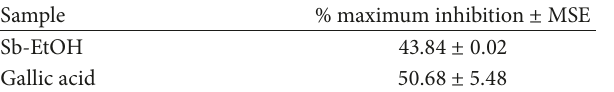
Table 2: Percentage of maximum inhibition of erythrocyte hemol- ysis induced by H 2 O 2 . Sample % maximum inhibition ± MSE Sb-EtOH 43.84 ± 0.02 Gallic acid 50.68 ± 5.48 MSE: Mean Standard